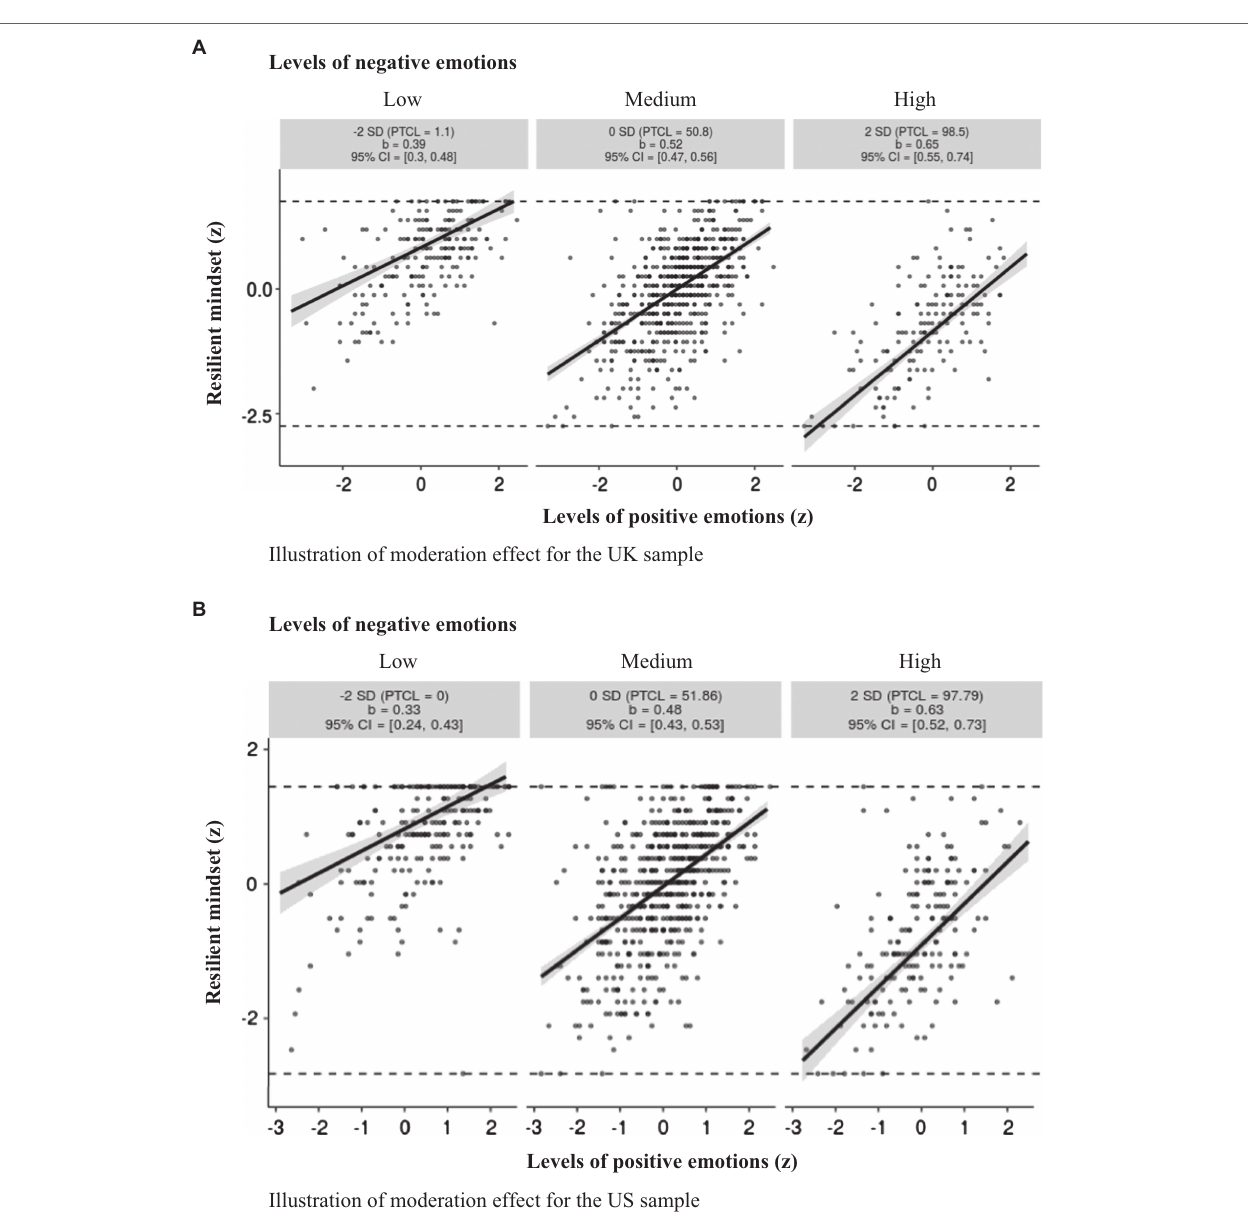
FIGURE 1 | Resilient mindset (standardized) as a function of an individual’s level of positive emotions (standardized), illustrated for very high (+2SD above mean), average (at the mean), and very low ( − 2SD below mean) levels of negative emotions, for the UK sample (A) and for the US sample (B) . Each graphic shows the computed 95% confidence region (shaded area) and the full range of the observed data (gray circles). CI, confidence